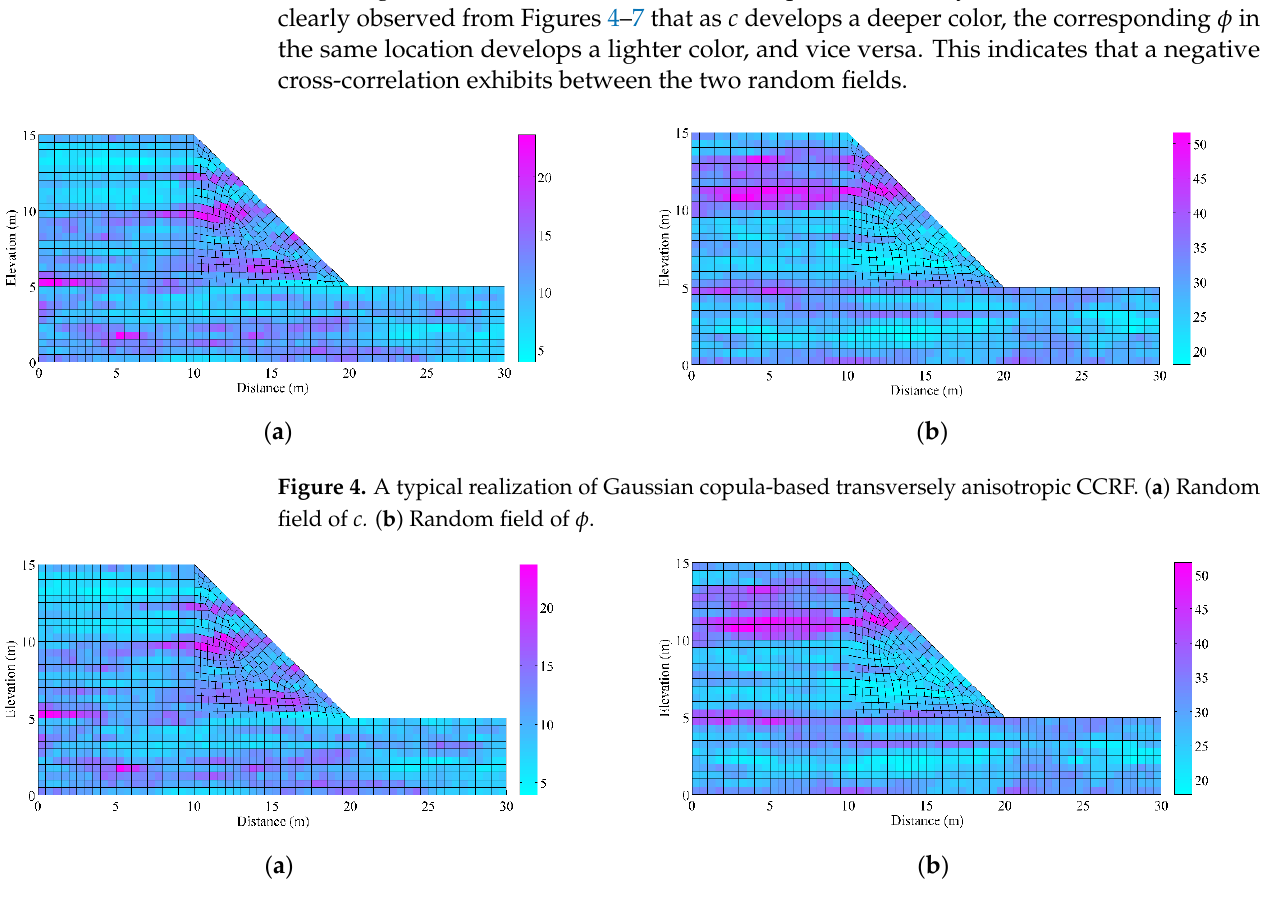
Figure 6. A typical realization of Frank copula-based transversely anisotropic CCRF. ( a ) Random field of c. ( b ) Random field of ϕ.